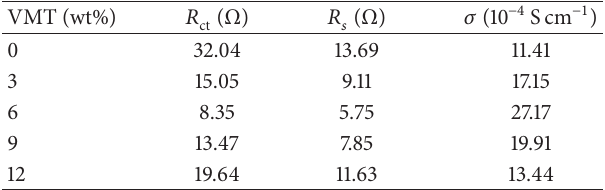
Table 1: The results for the 𝑅 based gel electrolytes with various contents of VMT.